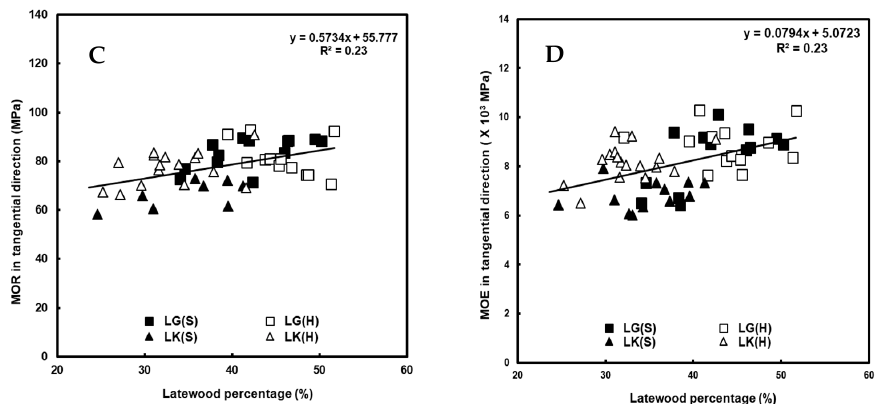
Figure 2. Relationship between latewood percentage and bending properties in the radial ( A , B ) and tangential directions ( C , D ) of the sample species. LG: Larix gmelinii ; LK: Larix kaempferi ; S: Sapwood; H: Heartwood.